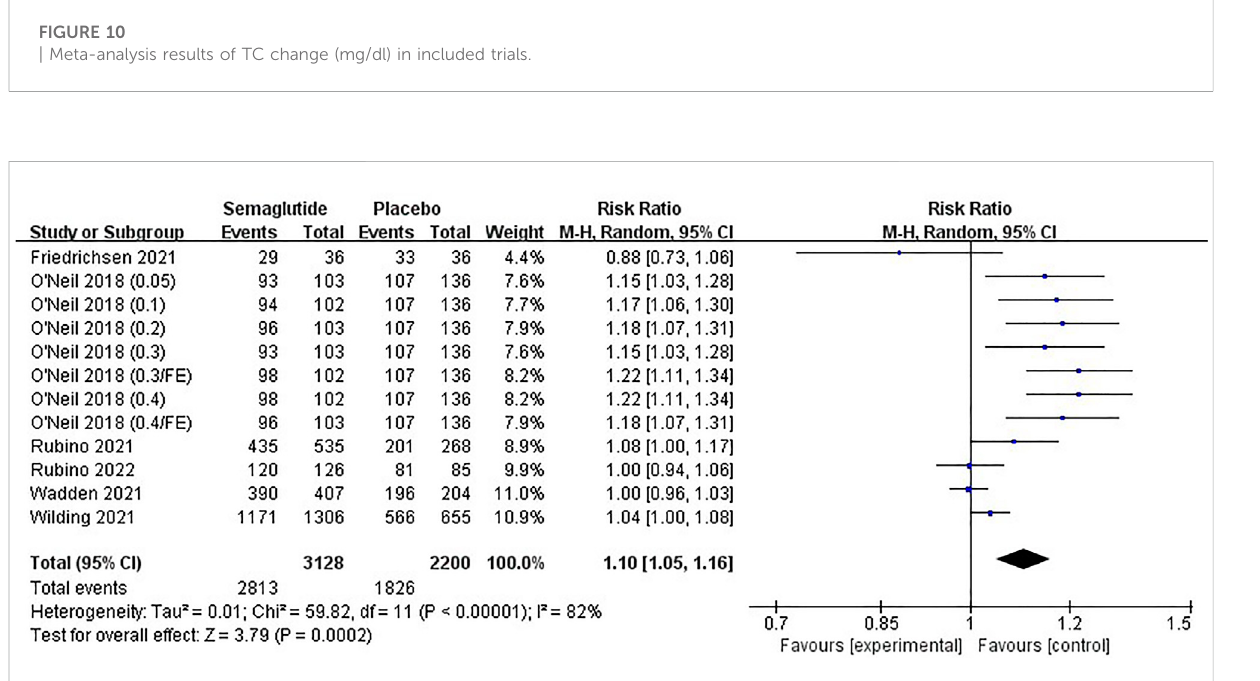
FIGURE 11 Meta-analysis results of the proportion with AEs in included